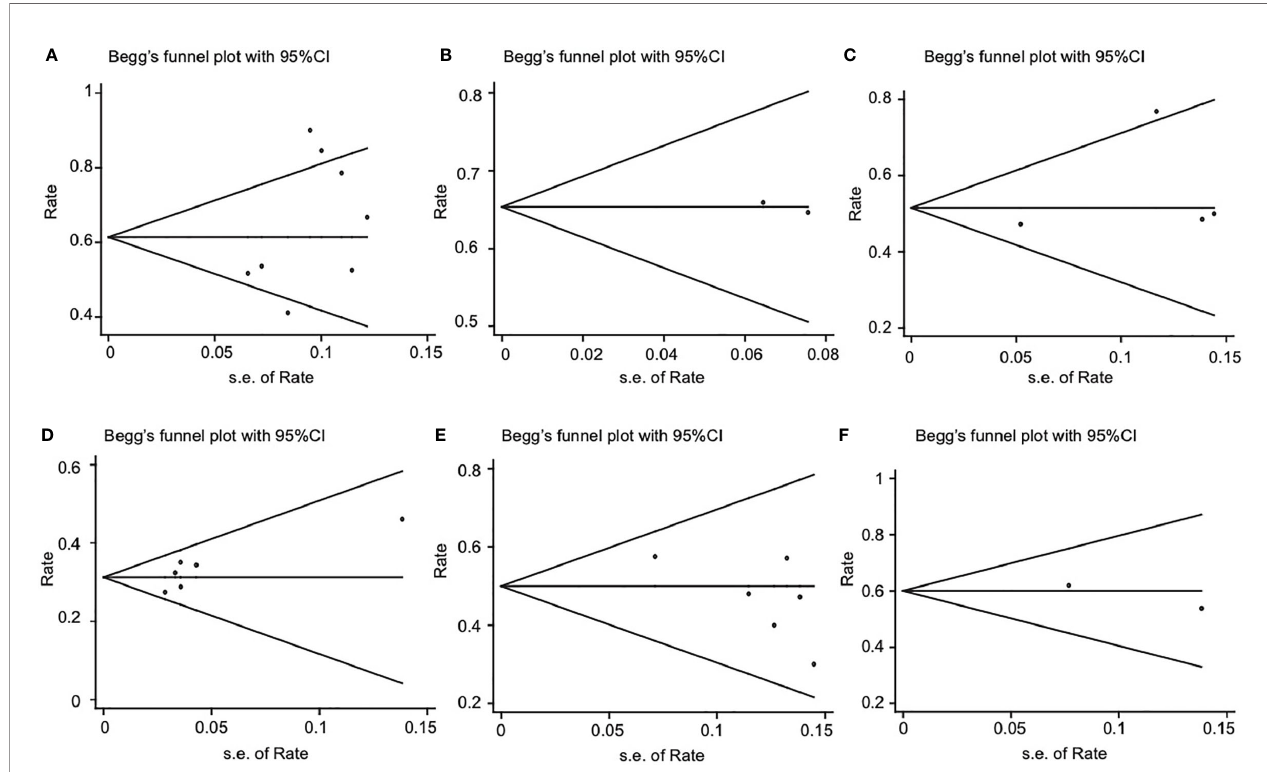
FIGURE 6 | Funnel plots for publication bias of 2-year OS, 5-year OS, 2-year DFS. (A) 2-year OS of endoscopic surgery. (B) 2-year OS of IMRT. (C) 5-year OS of endoscopic surgery. (D) 5-year OS of IMRT. (E) 2-year DFS of endoscopic surgery. (F) 2- year DFS of IMRT. OS, overall survival; DFS, disease-free